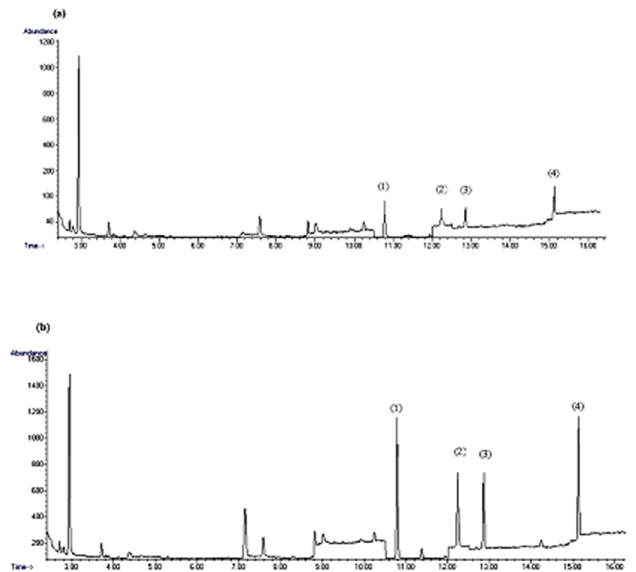
Figure 3. The chromatogram of ( a ) non-spiked and ( b ) spiked sample at a concentration 1000 ng g − 1 of BAs. Putrescine (1), cadaverine (2), histamine (3) and tyramine (4) by the proposed method under optimum conditions.